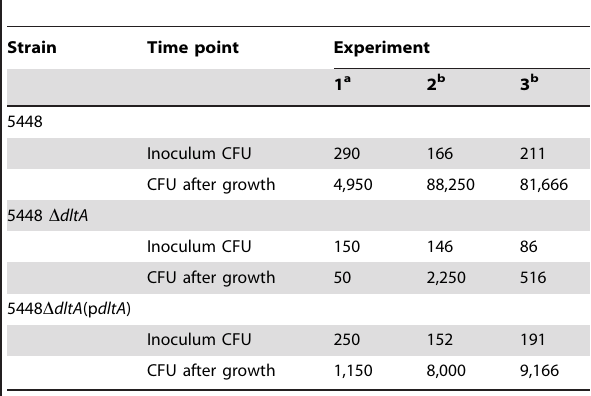
Table 2. Growth of Bacteria in Human